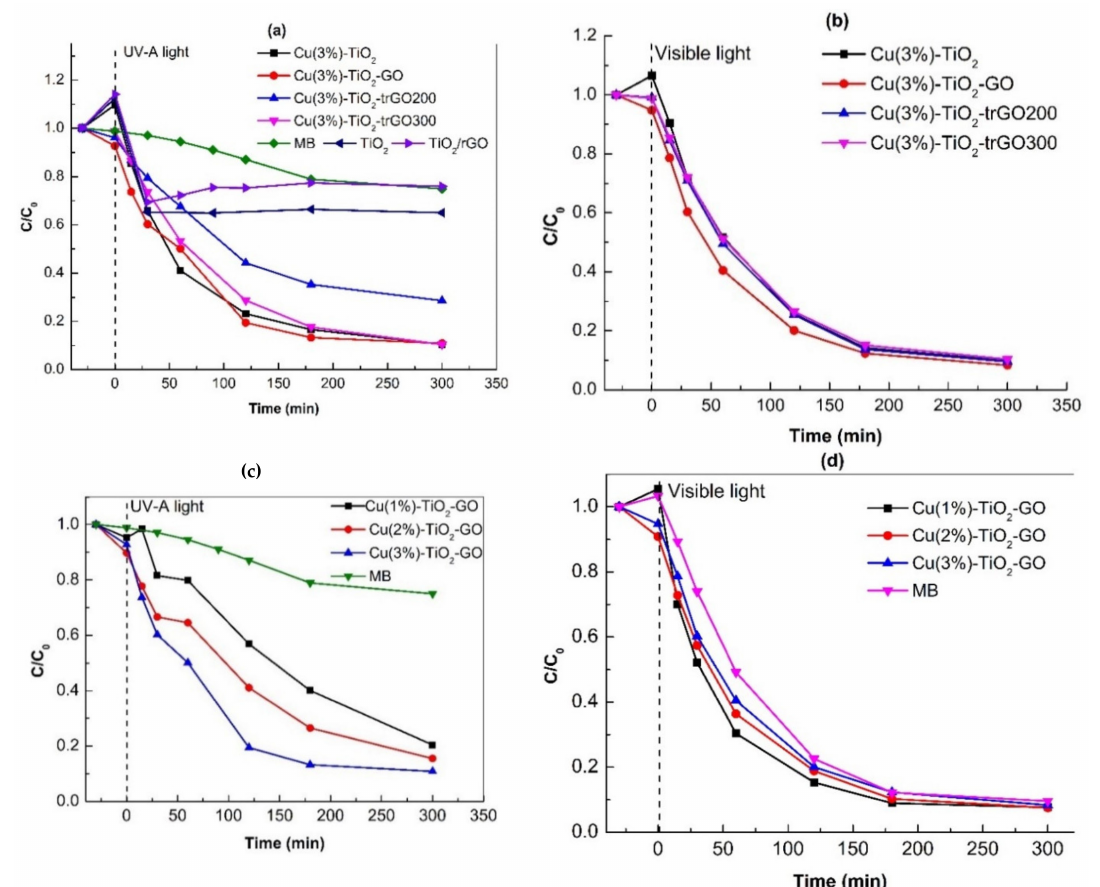
Figure 5. Residual ratio of MB (starting 5.5 mg/L) after UV-A irradiation ( a , c ), and visible light exposure ( b , d ), at a 0.5 mg/mL photocatalyst